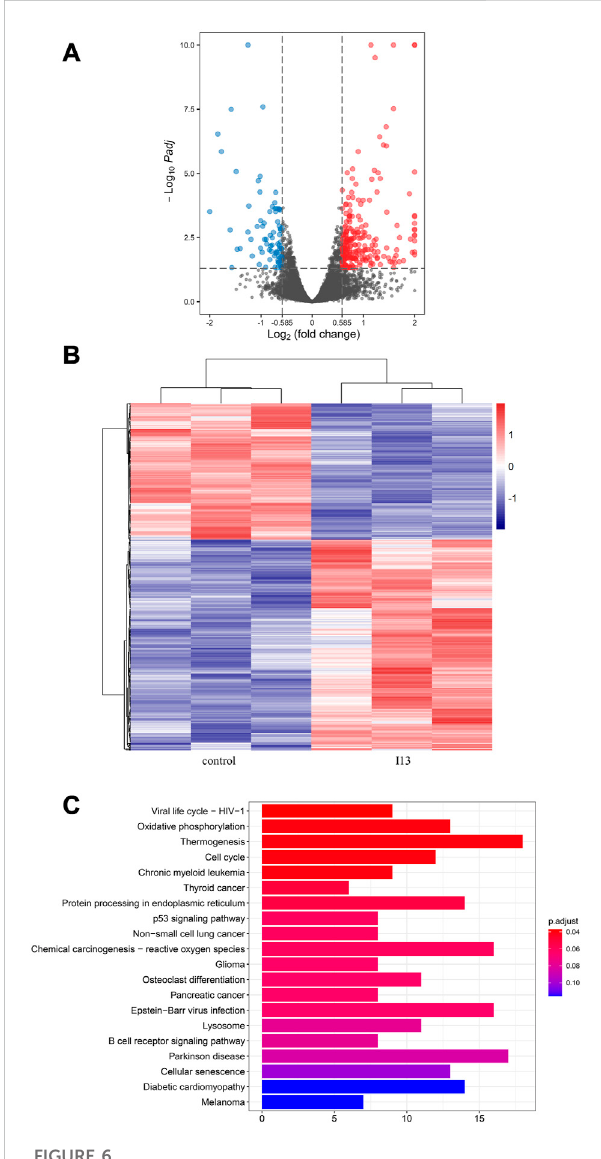
FIGURE 6 mRNAsequencinganalysisinBaF3-T315IcellsexposedtoI13. (A) Volcano plots of differentially expressed genes. (B) The cluster heatmap of differentially expressed genes. (C) KEGG pathway analysis of DEGs. BaF3-T315I cells were stimulated with I13 at 1.1 µM for 48